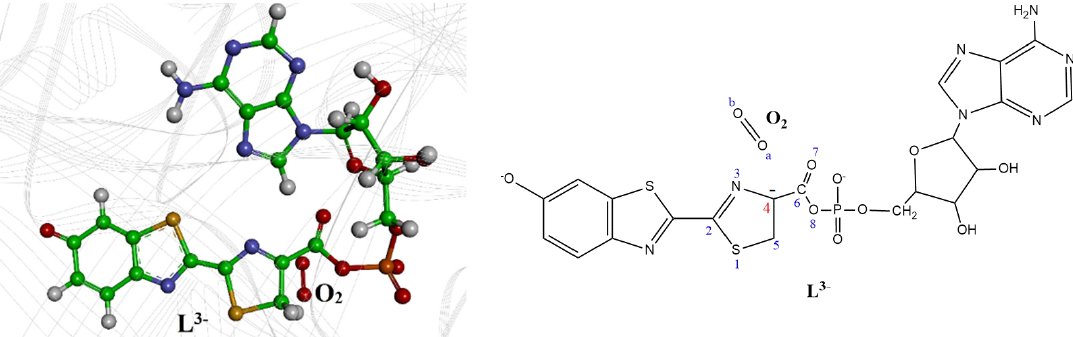
Figure 2. QM/MM computational model. The gray ribbon in the background represents the protein environment ( left ). The atomic labels for key atoms ( right ). For details see Figure S2.